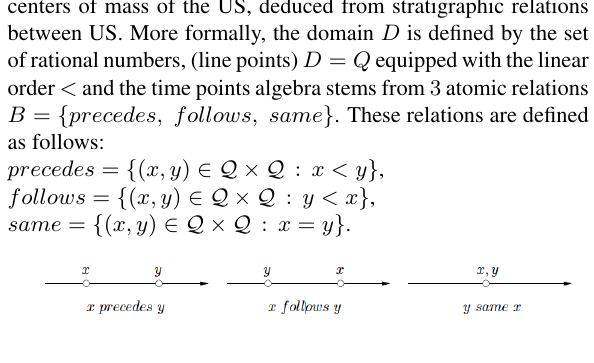
Figure 6. Time points algebra atomic relations